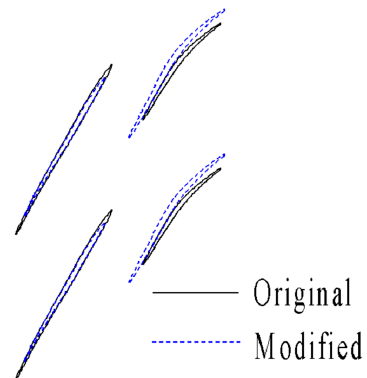
Figure 9. Comparison of basic and optimization airfoil.